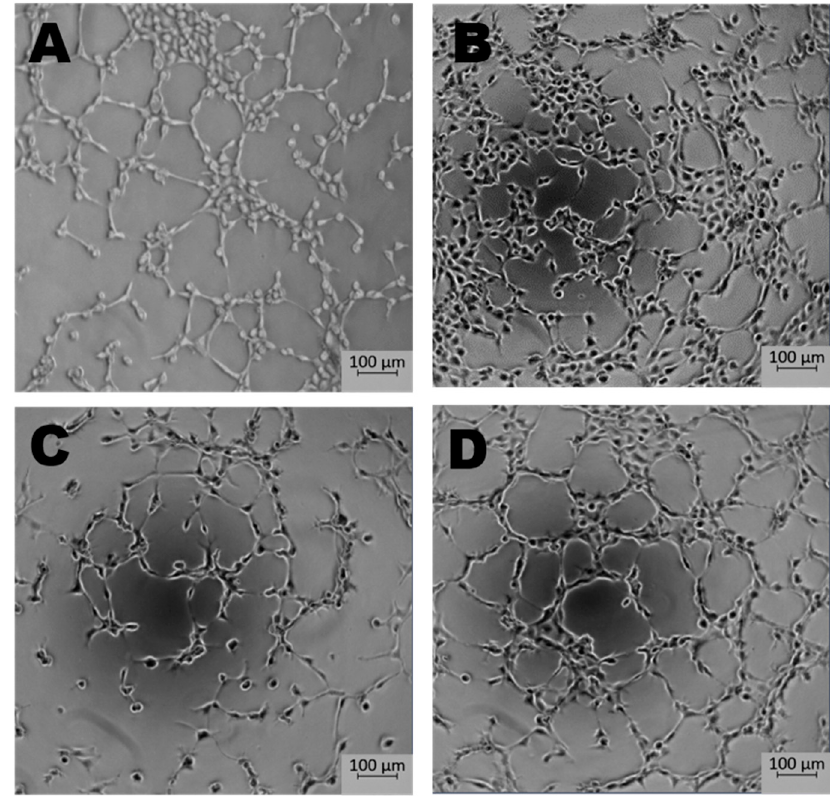
Figure 3. The effect of microenvironment and organospecificity on the angiogenic potential of Endothelial cells (ECs). Morphology of tubes formed in vitro by healthy and cancer-derived EC cells after 5 h in normoxia or hypoxia. Low pO 2 reduces the pro-angiogenic response in ECs derived from tumor site when compared to normoxia. In the case of healthy tissue-derived ECs, hypoxia does not significantly influence tube formation. ( A )—healthy ECs, normoxia; ( B )—healthy ECs, hypoxia; ( C )—cancer-derived ECs, normoxia; ( D )—cancer-derived ECs, hypoxia; magnification 5 ×